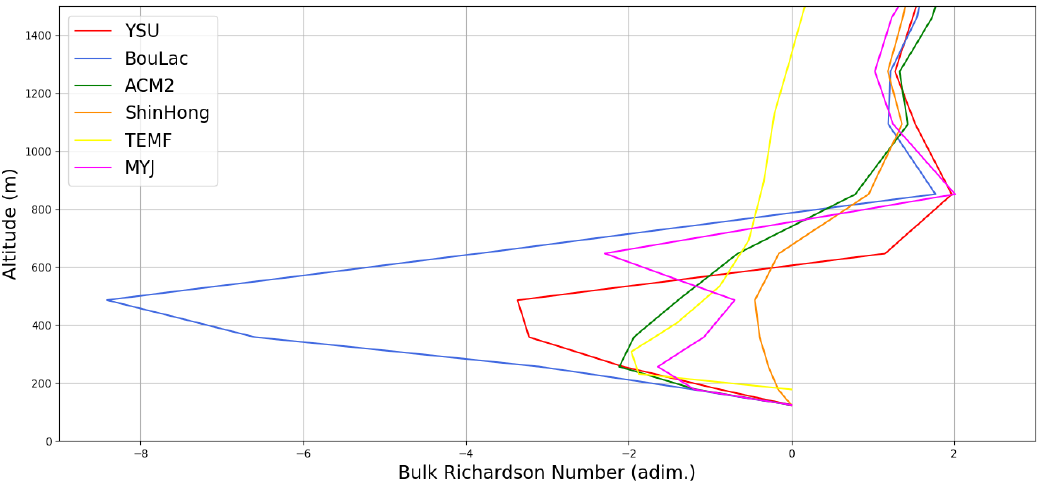
Figure 19. Simulated bulk Richardson number profiles compared with one another, 04/04/2016, 14:00, red: simulated data with YSU parametrization, blue: simulated data with BouLac parametrization, green: simulated data with ACM2 parametrization, orange: simulated data with ShinHong parametrization, yellow: simulated data with TEMF parametrization, purple: simulated data with MYJ parametrization.